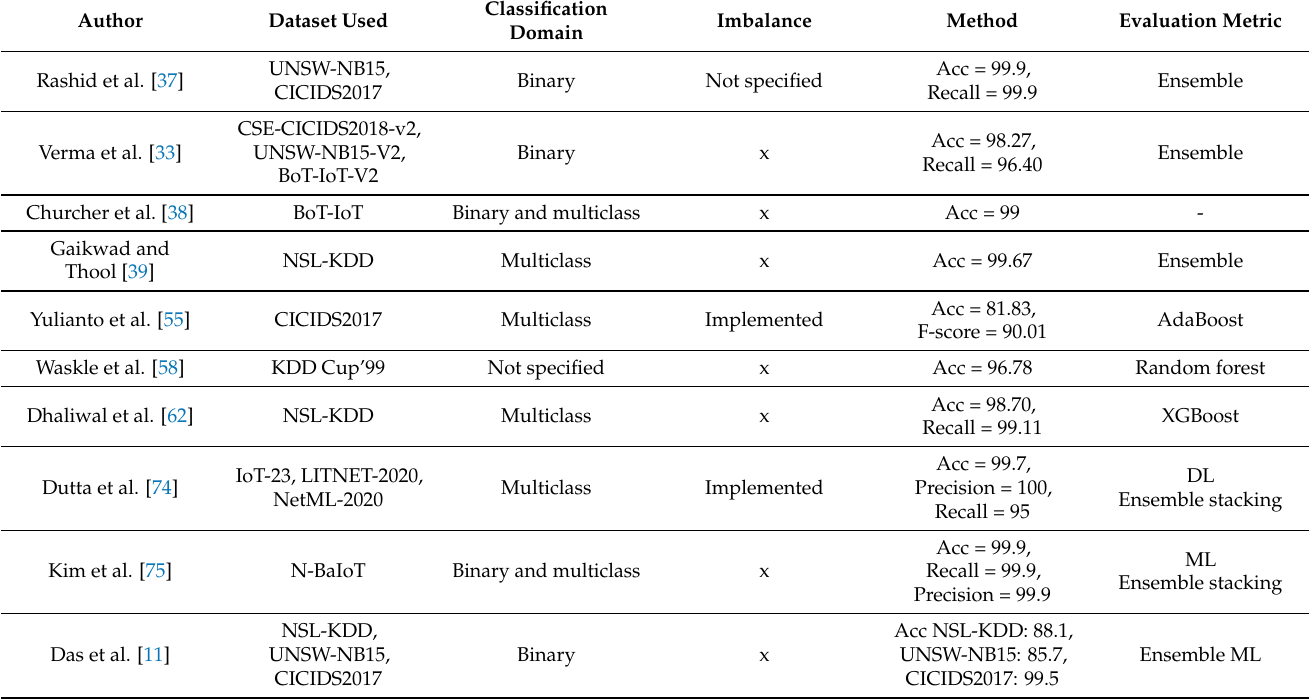
Table 1. Outline of related works that implement machine learning and deep learning in both single and ensemble scenarios for intrusion detection in IoT